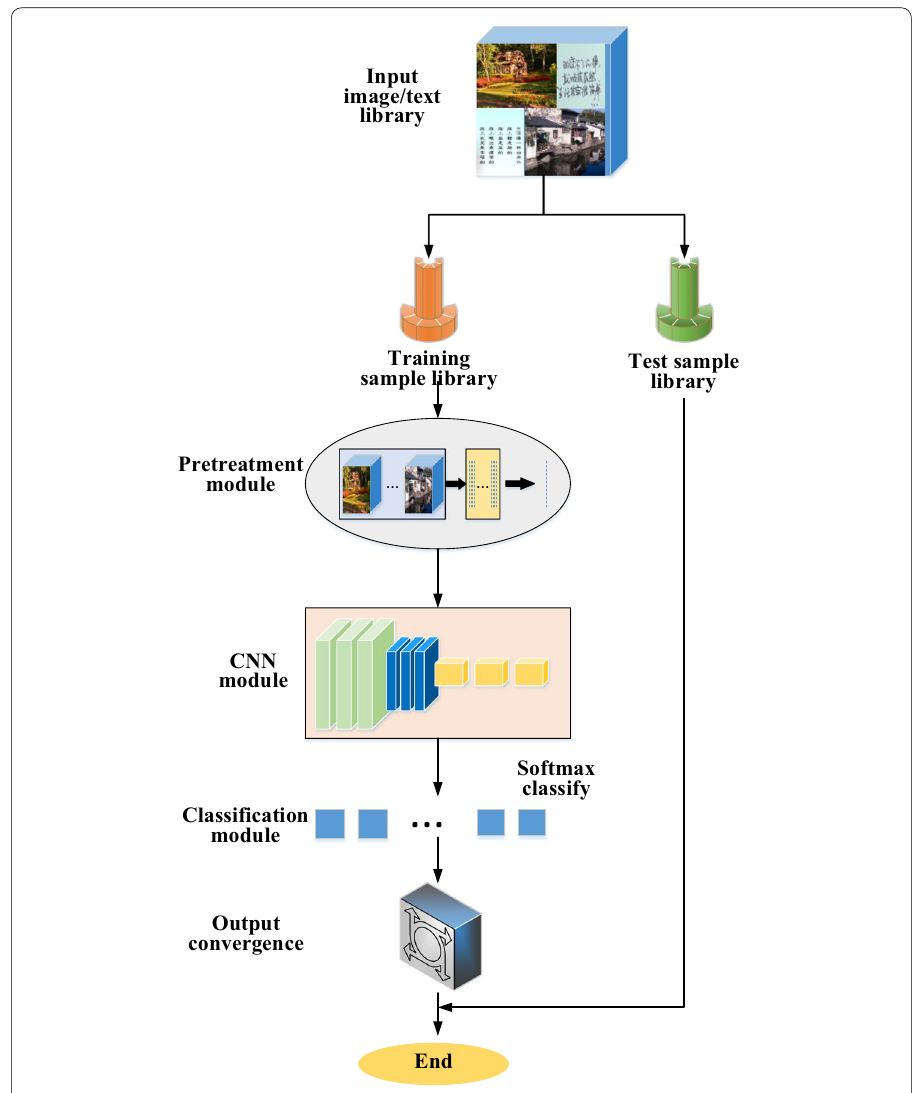
Fig. 3 Structure of CNN real-time image text encryption